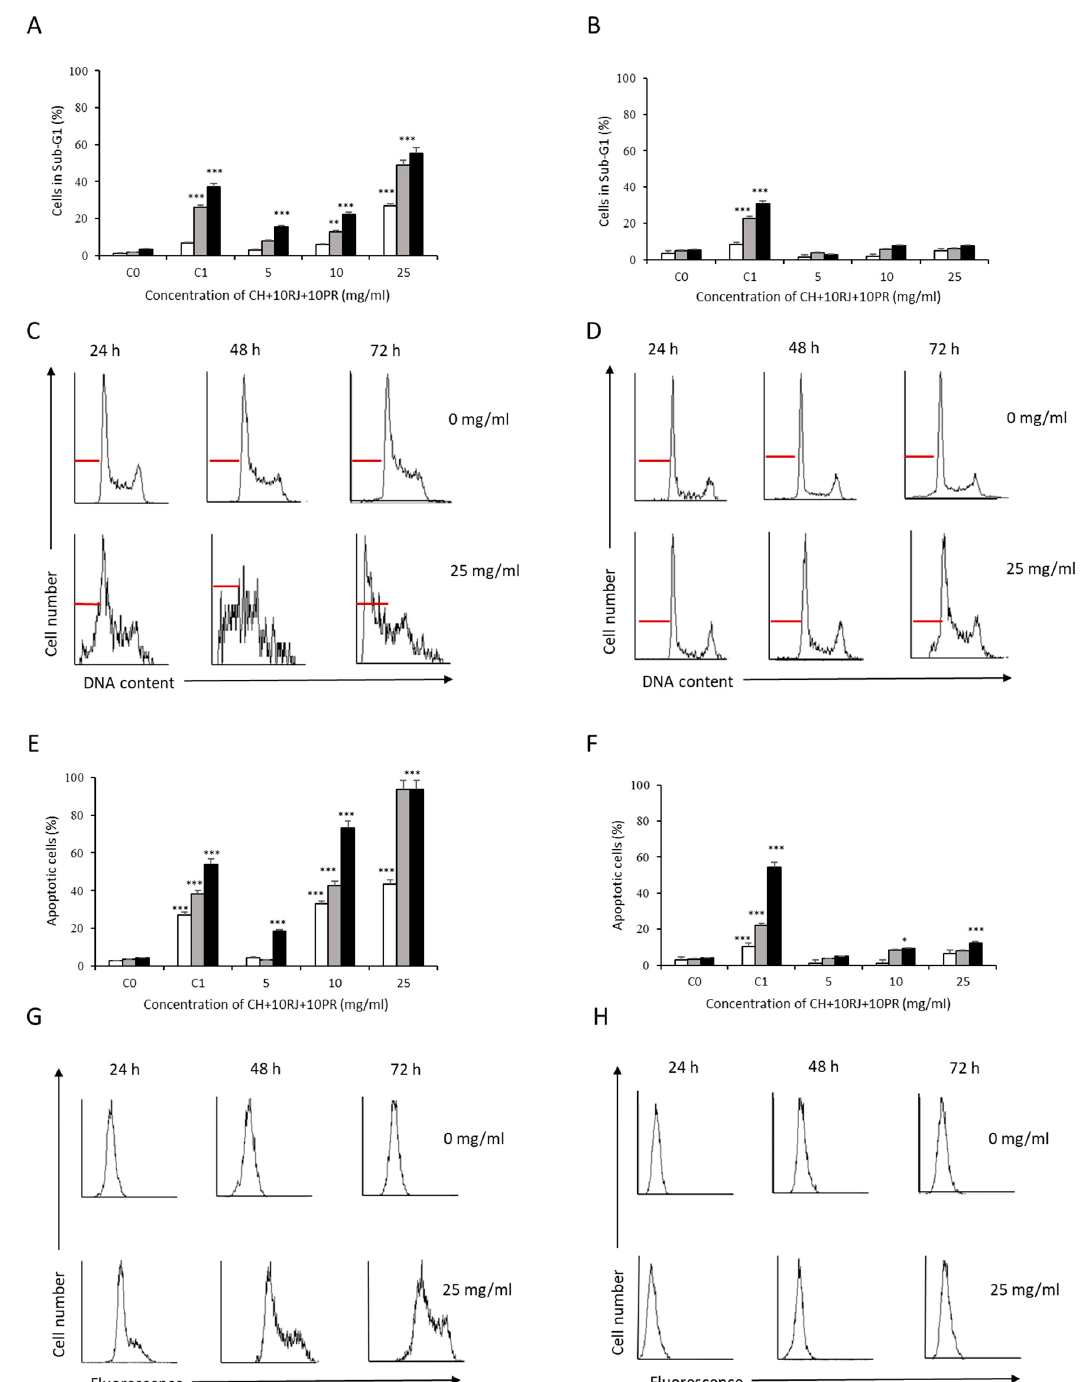
Figure 11. Effect of sample 14 (CH+10RJ+10PR) on human liver cell apoptosis. The cell cycle was determined using flow cytometry. HepG2 ( A ) and WRL-68 ( B ) cells were treated with different doses of sample 14 (5, 10, and 25 mg/mL) for 24 ( □ ), 48 ( ■ ), and 72 h ( ■ ). Representative histograms of the cell cycle of HepG2 ( C ) and WRL-68 ( D ) cells are shown; the red line indicates the sub-G1 phase. The percentage of apoptosis was analyzed by flow cytometry using the TUNEL assay. HepG2 ( E ) and WRL-68 ( F ) cells were cultured with different doses of sample 14 (5, 10, and 25 mg/mL) for 24 ( □ ), 48 ( ■ ), and 72 h ( ■ ). Representative histograms of the fluorescence intensity in HepG2 ( G ) and WRL-68 ( H ) cells are presented. C 0 , untreated cells; C 1 , cells treated with etoposide (50 µM). Asterisks indicate a significant difference from the control (C 0 ). * p ≤ 0.05,** p ≤ 0.01,*** p ≤ 0.001.